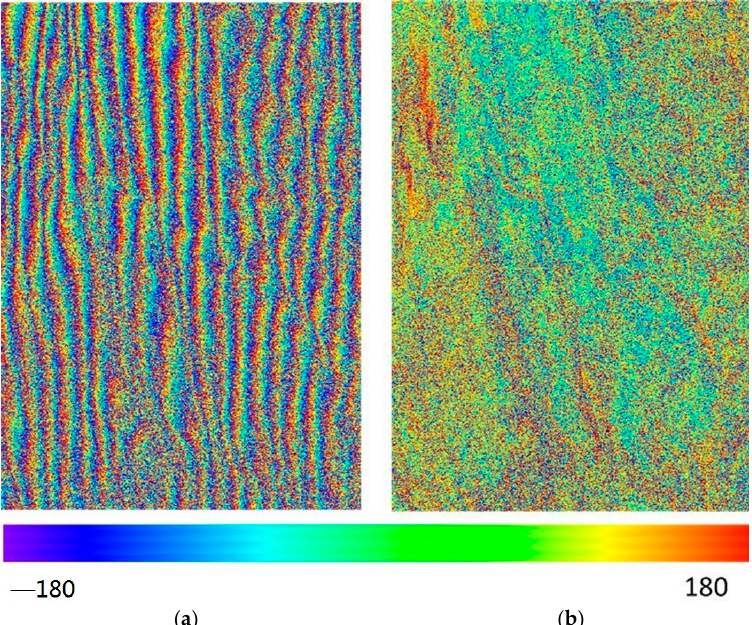
Figure 5. The interferometric phase diagram of the 93–95 image pair in HV polarization. ( a ) Before removal of terrain phase; ( b ) After removal of terrain phase